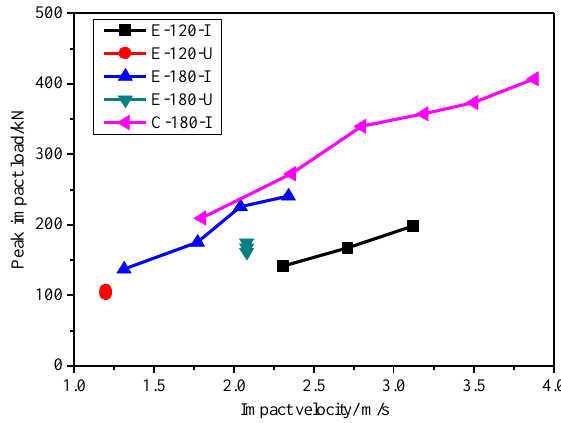
Figure 6. Effect of the impact velocity on the peak impact force.